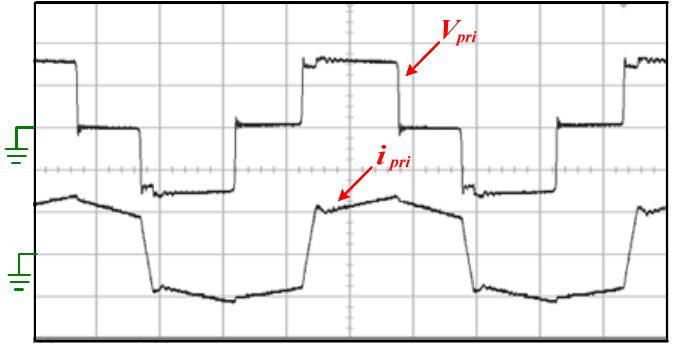
Figure 18. Measured primary voltage and current waveforms of transformer. V : 100 V/div; i : 2 A/div; time: 5 µs/div. pri pri